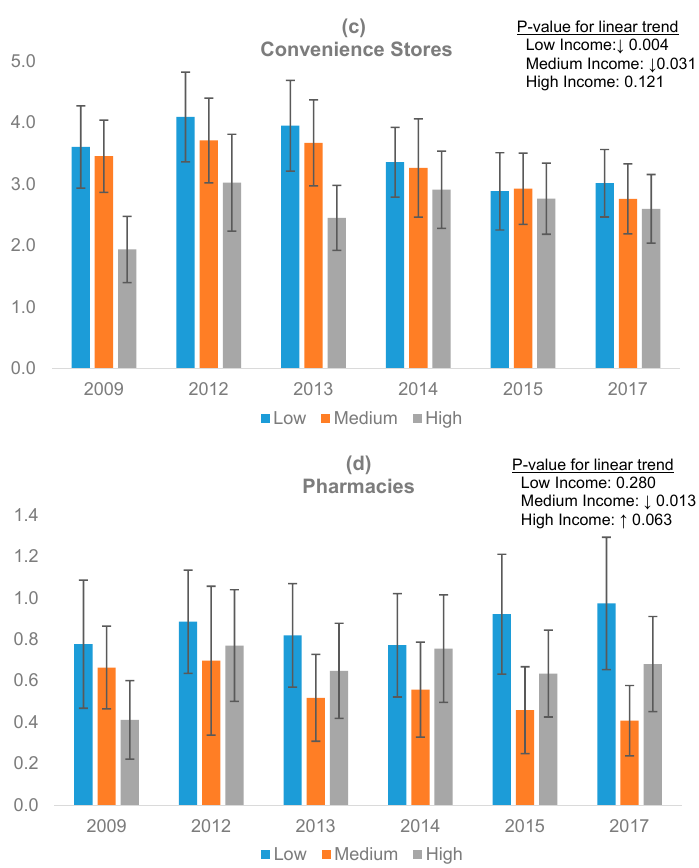
Figure 1. Expected number of ( a ) supermarkets; ( b ) small grocery stores; ( c ) convenience stores; ( d ) pharmacies per census tract by income group. Year-by-year di ff erences: Supermarkets: No di ff erences were observed. Small grocery stores: In 2014 medium-income tracts had a significantly higher number of small grocery stores than did lower- and higher-income tracts. In 2015 small grocery stores were more prevalent in lower income tracts than they were in higher income tracts. Convenience stores: In 2009 and 2013 low-income and medium-income tracts had significantly more convenience stores than did higher-income tracts. Pharmacies: Lower-income tracts had significantly more pharmacies than medium-income tracts in 2015 and 2017. ↓ : indicates a declining linear trend over time; ↑ : indicates an increasing linear trend over time. Int. J. Environ. Res. Public Health 2019 , 16 , x